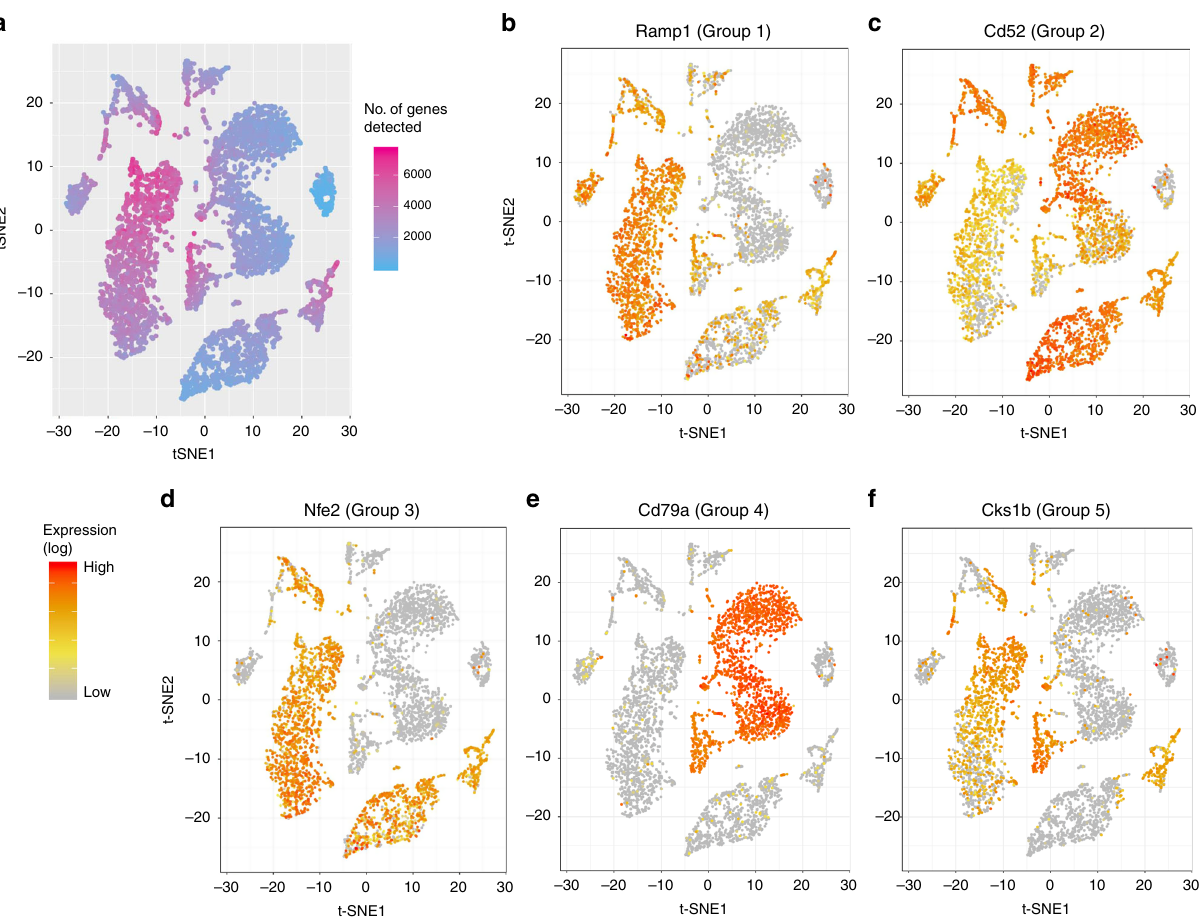
Fig. 3 Application of singleCellHaystack on bone marrow tissue dataset. a t-SNE plot of the 5250 cells. The color scale shows the number of genes detected in each cell. b – f Expression patterns of fi ve high-scoring DEGs, representative of the fi ve groups in which the genes were